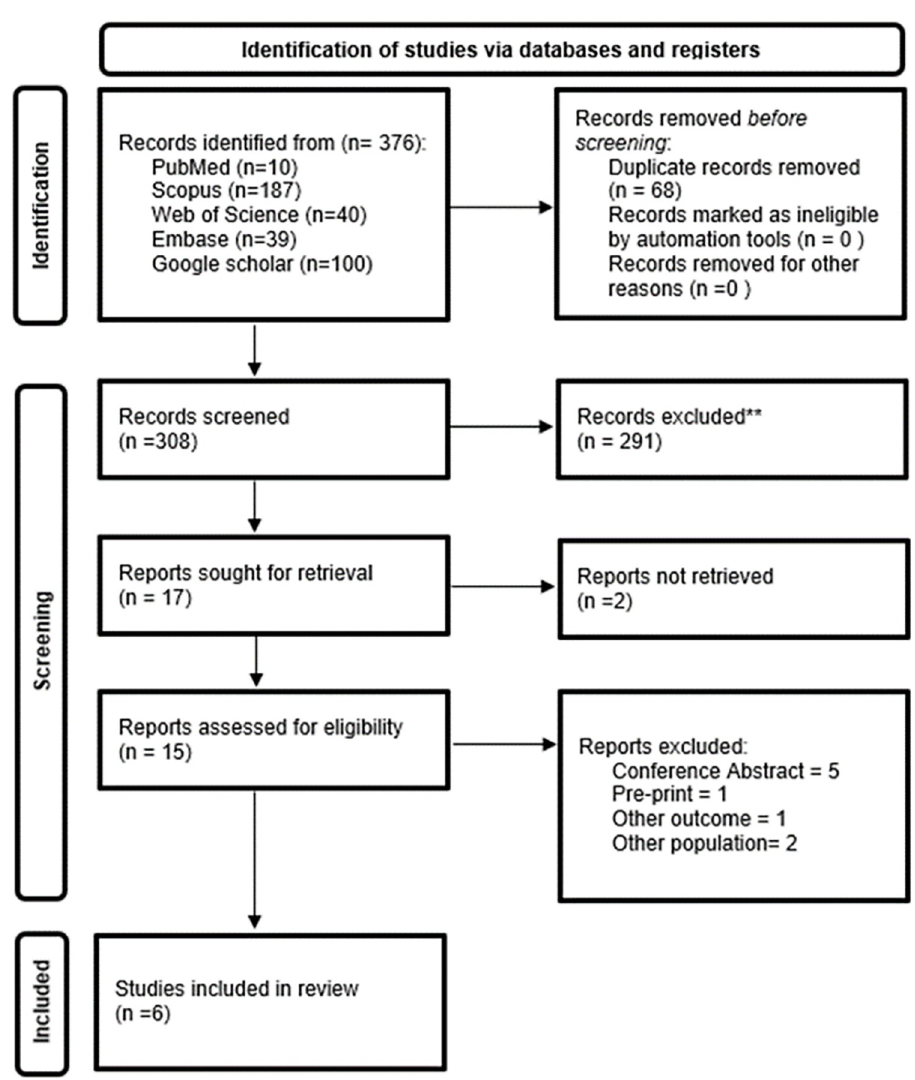
Fig 1. PRISMA flowchart of included